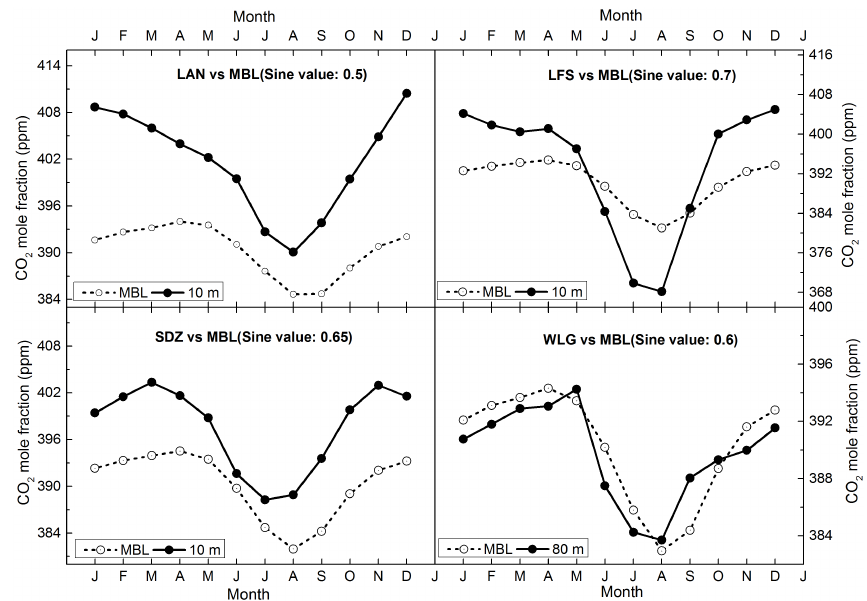
Fig. 7. Variations of monthly CO 2 mole fractions at LAN, LFS, SDZ, and WLG during the period 2009 to 2011. Also compare to the surface values at similar latitudes from the MBL reference (Conway et al., 2012b). LAN compares to those of sine of latitude value 0.5, WLG with 0.6, SDZ with 0.65, and LFS with 0.7. The closed circles and solid line denote the monthly averaged CO 2 concentration at the four stations. The open circles and dashed lines denote the monthly average CO 2 values from the MBL reference. The data in this figure are smoothed from the filtered CO 2 mole fractions (regionally representative for LFS, SDZ, LAN, and background for WLG) by the curve-fitting method of Thoning et al.